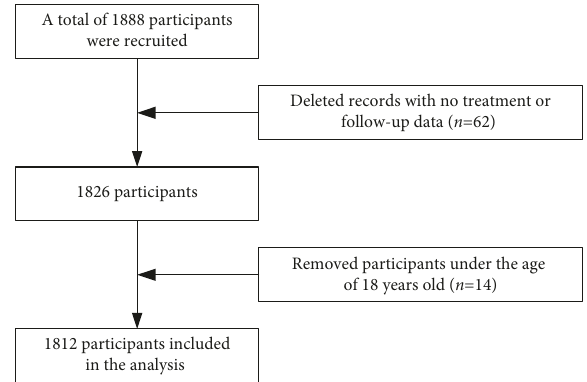
Figure 1: A flowchart of participants was included in the statistical Table 1: General demographic characteristics and bivariate Cox proportional hazards regression model analyses.